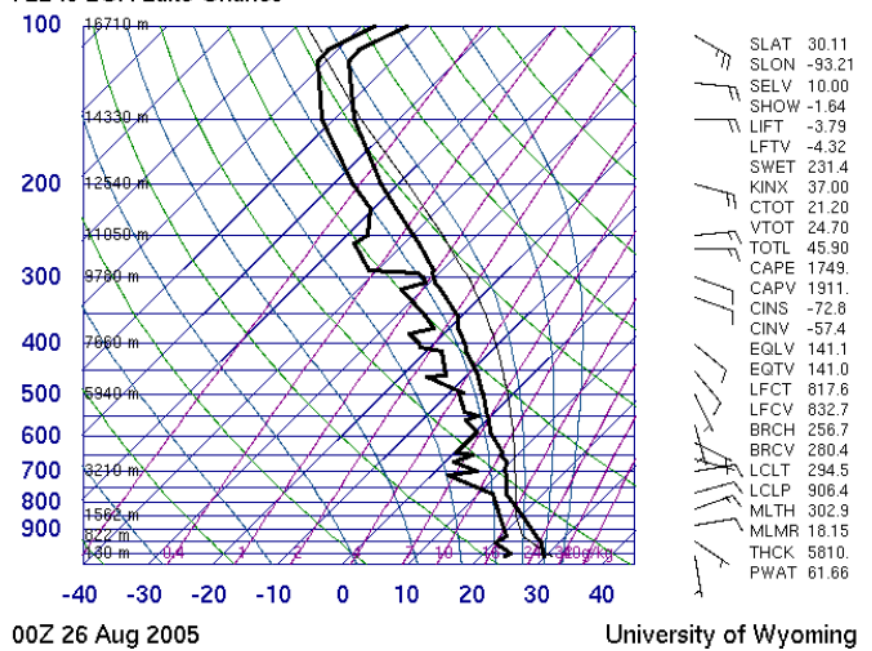
Figure 11. The atmospheric soundings over the Lake Charles station on 26 August 2005, from the data provided by the University of Wyoming’ department of atmospheric sciences [23]. The observed sounding indices showed still higher values of 1746 J/kg for the CAPE at the equilibrium level (EL) about two days before the hurricane Katrina